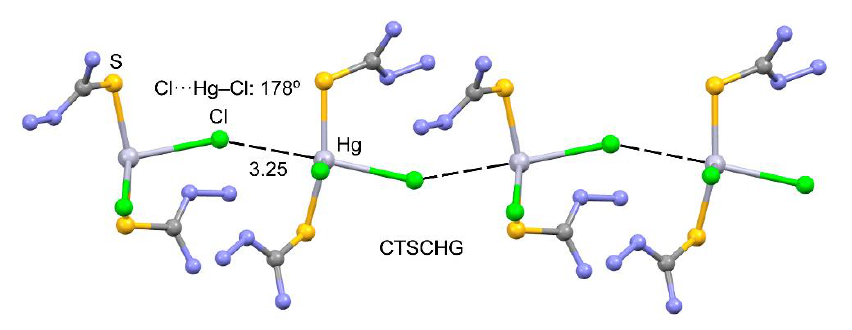
Figure 7. Spodium complexes of ZnCl 2 . Distances in Å . The CSD reference code is